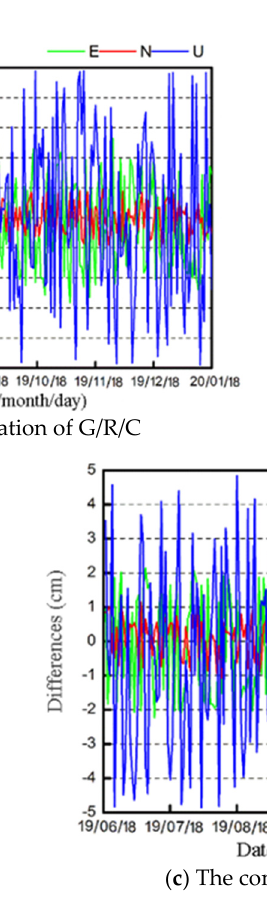
Figure 11. Comparison of difference between combined PPP and static relative positioning results. Table 1. The PPP positioning results compared with the results of static relative positioning difference and the RMSE.